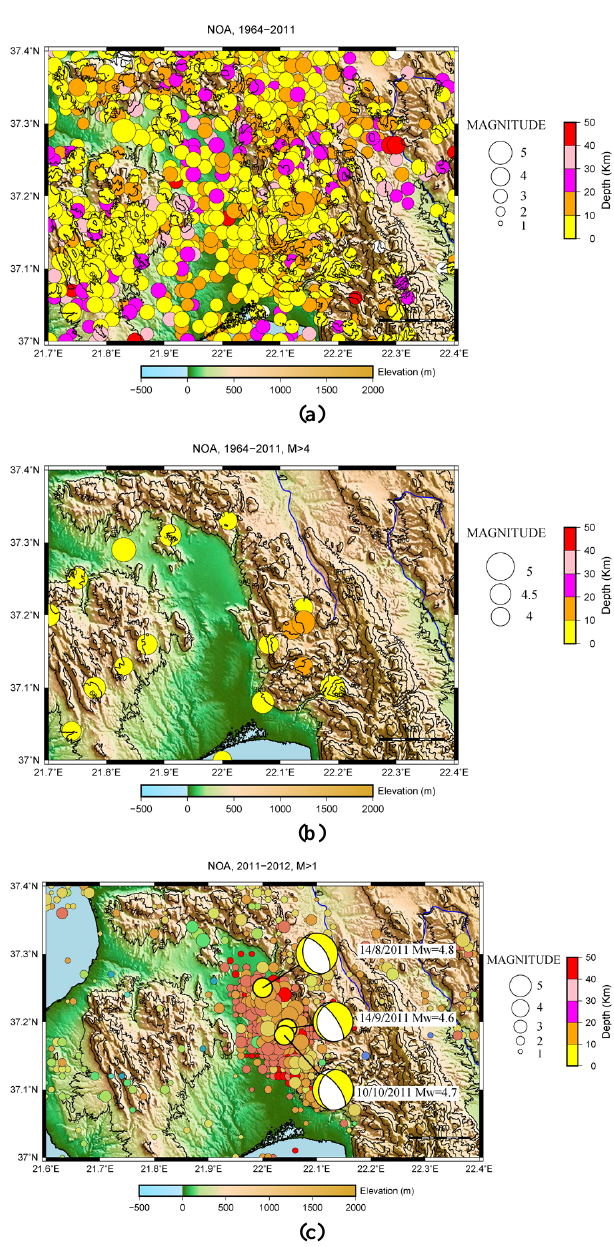
Fig. 2. Seismicity maps of the Messinia basin for (a) the instru- mental period 1964–2011, (b) the large seismic events with M > 4 from 1964–2011, (c) the 2011 seismic swarm cluster for the period June 2011–June 2012. Beach balls indicate the NOA-CMT solu- tions for the three largest